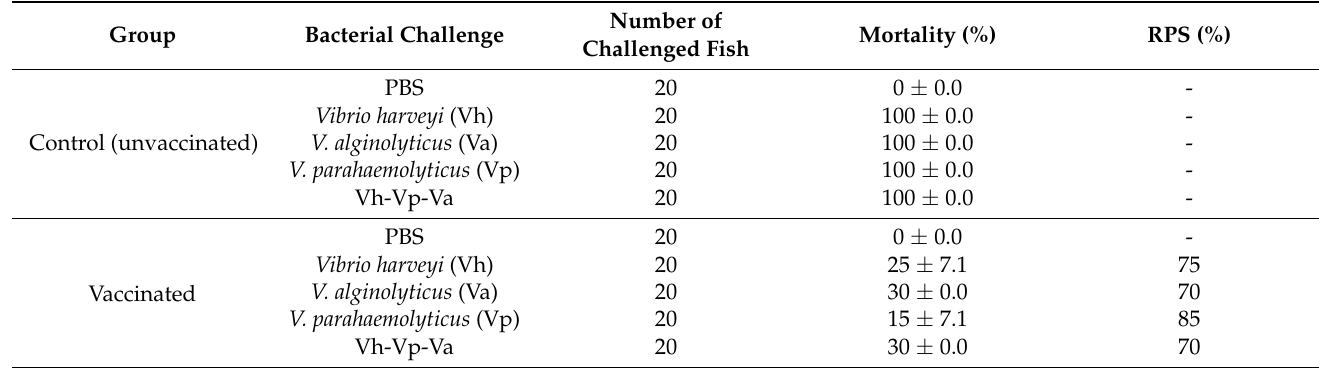
Table 4. Comparative efficacy of oral Vibrio harveyi strain VH1 vaccine candidate against different Vibrio spp. in Asian seabass ( Lates calcarifer ).